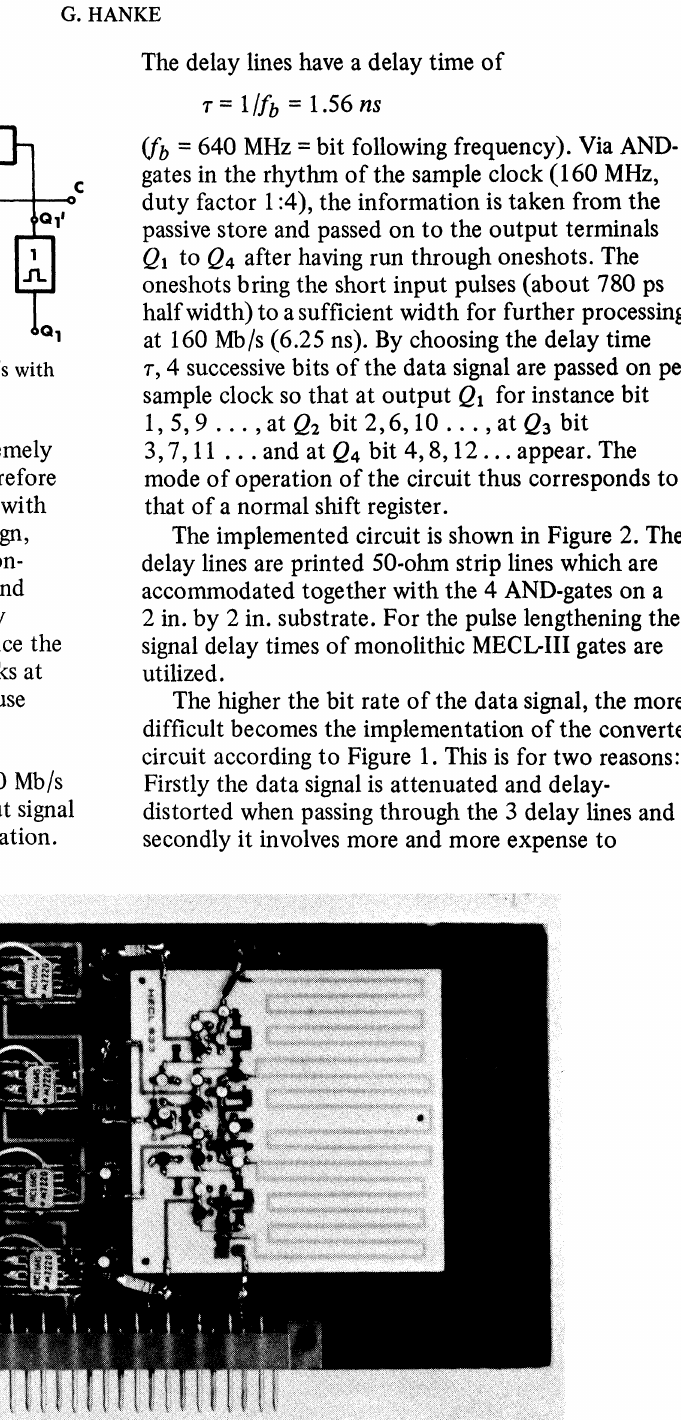
Series-to-parallel converter for 640 Mb/s. Size of the thickfilm circuit is 2 in. by 2 in., delay lines are printed strip lines. RF-connectors are mounted on the rear